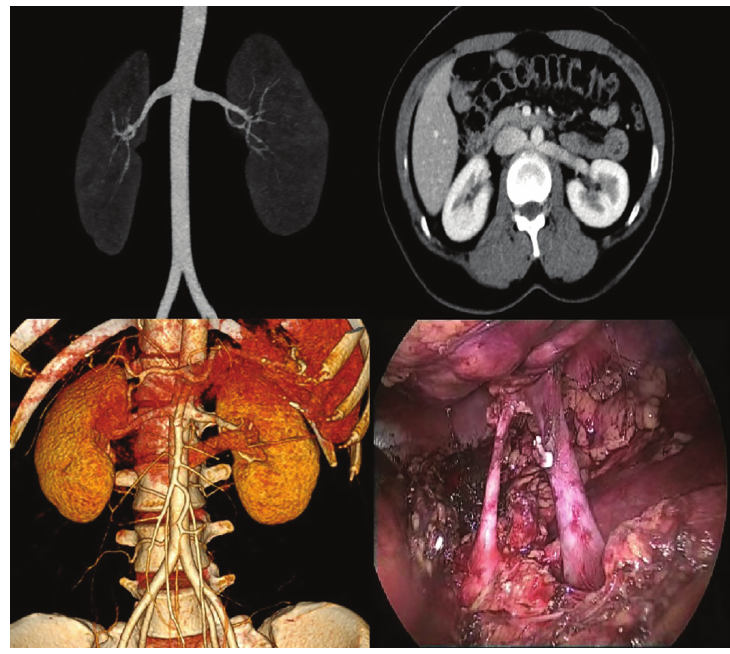
figure 2- Type II retroaortic left renal vein with bilateral single renal arteries.